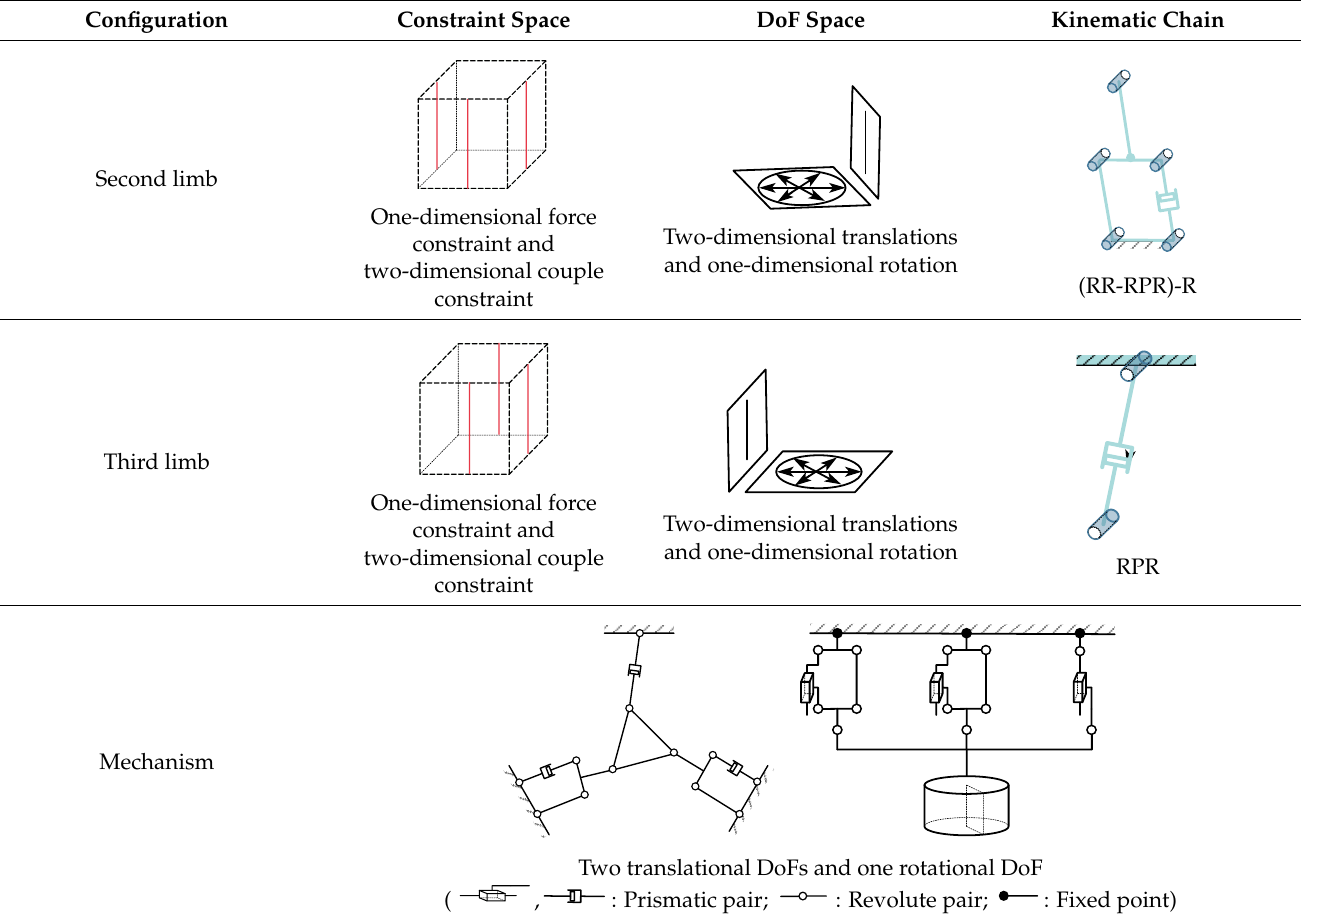
Table 1. The result of the type synthesis.